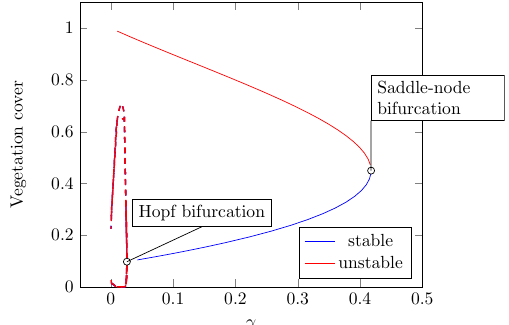
Figure 6. Bifurcation diagram, with the vegetation A plotted ver- sus the death rate γ . The branches were computed using the XPPAUT software package (Ermentrout,